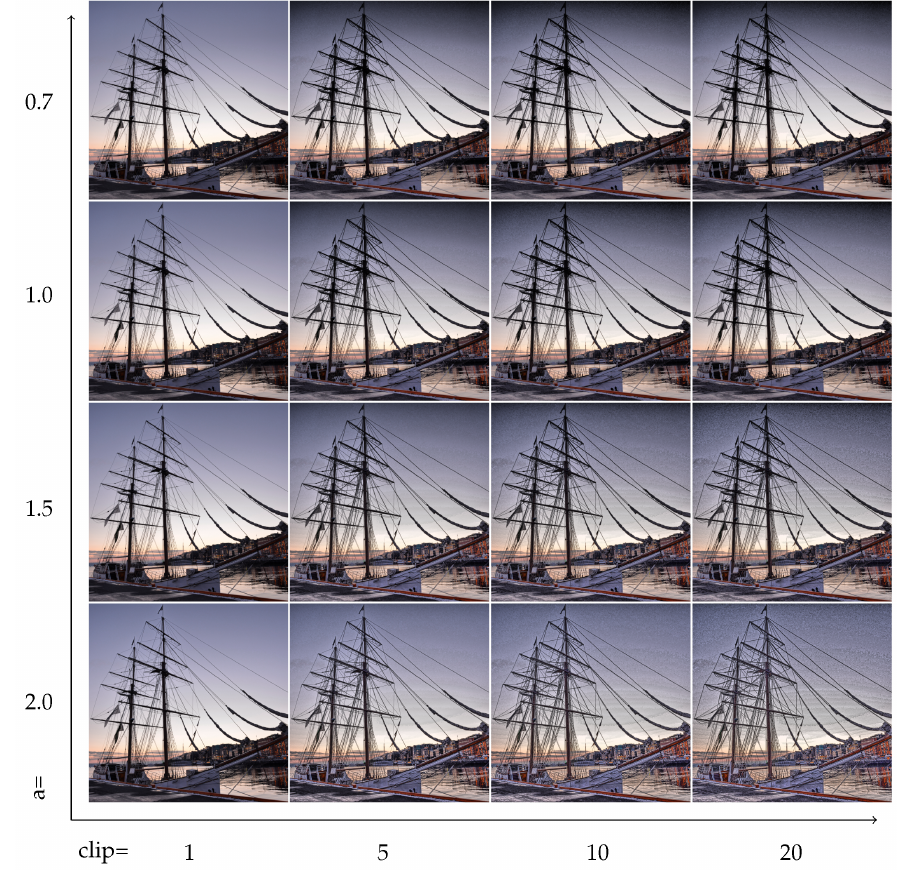
Figure 7. The effect of the 1/ r a weighting function and clipping. Rows from top to bottom have a = 0.7, 1.0, 1.5, 2.0, respectively, and the clip limits in the columns from left to right are 1, 5, 10 and 20, using 1/ N units where N is the number of histogram